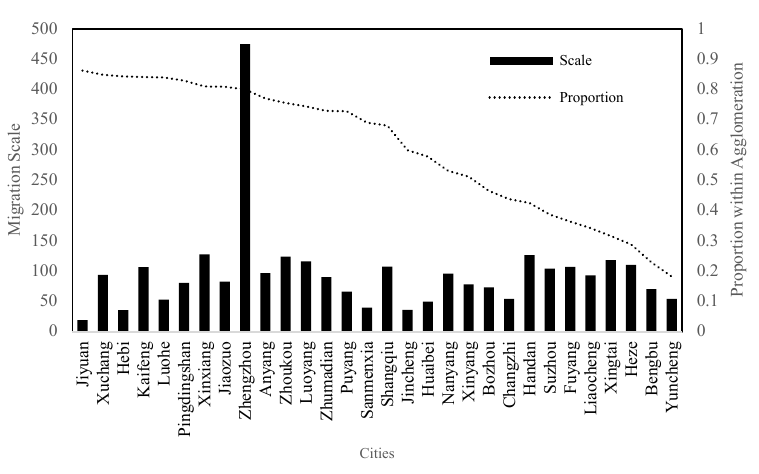
Figure 6. City point weight.